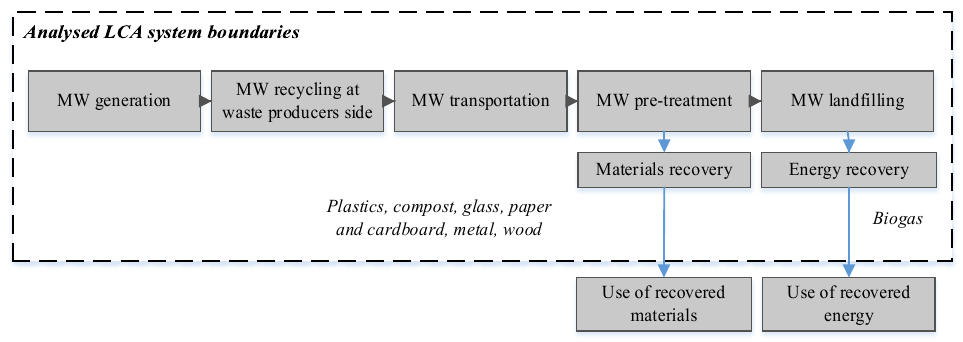
Fig. 1. Technological boundaries of the analysed